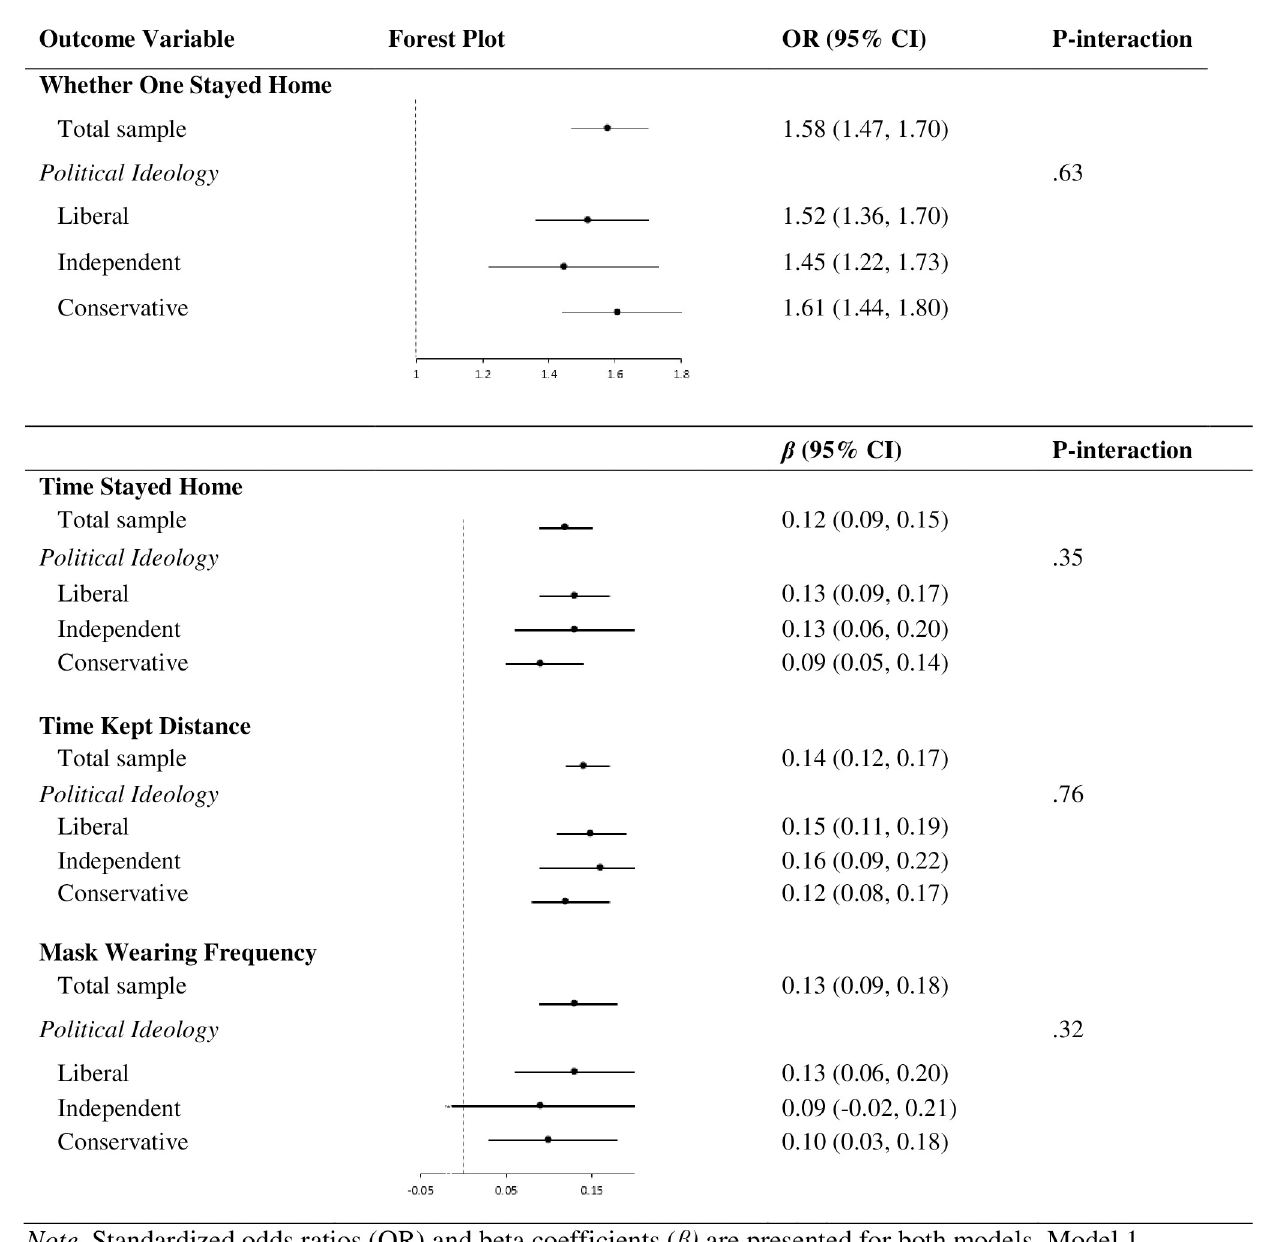
Fig 1. Depicts the forest plots for the associations (standardized odds ratios or beta coefficients) between compassion and three health behaviors: Whether one stayed home, time stayed home, time keeping distance from others, and mask wearing frequency. The first forest plot for each health behavior outcome is for the total sample, and the following three forest plots are for the sub-groups of liberal-leaning, independent, and conservative- leaning participants. The figure also depicts the 95% confidence intervals and the p-value for the interaction term between compassion and the continuous variable of political